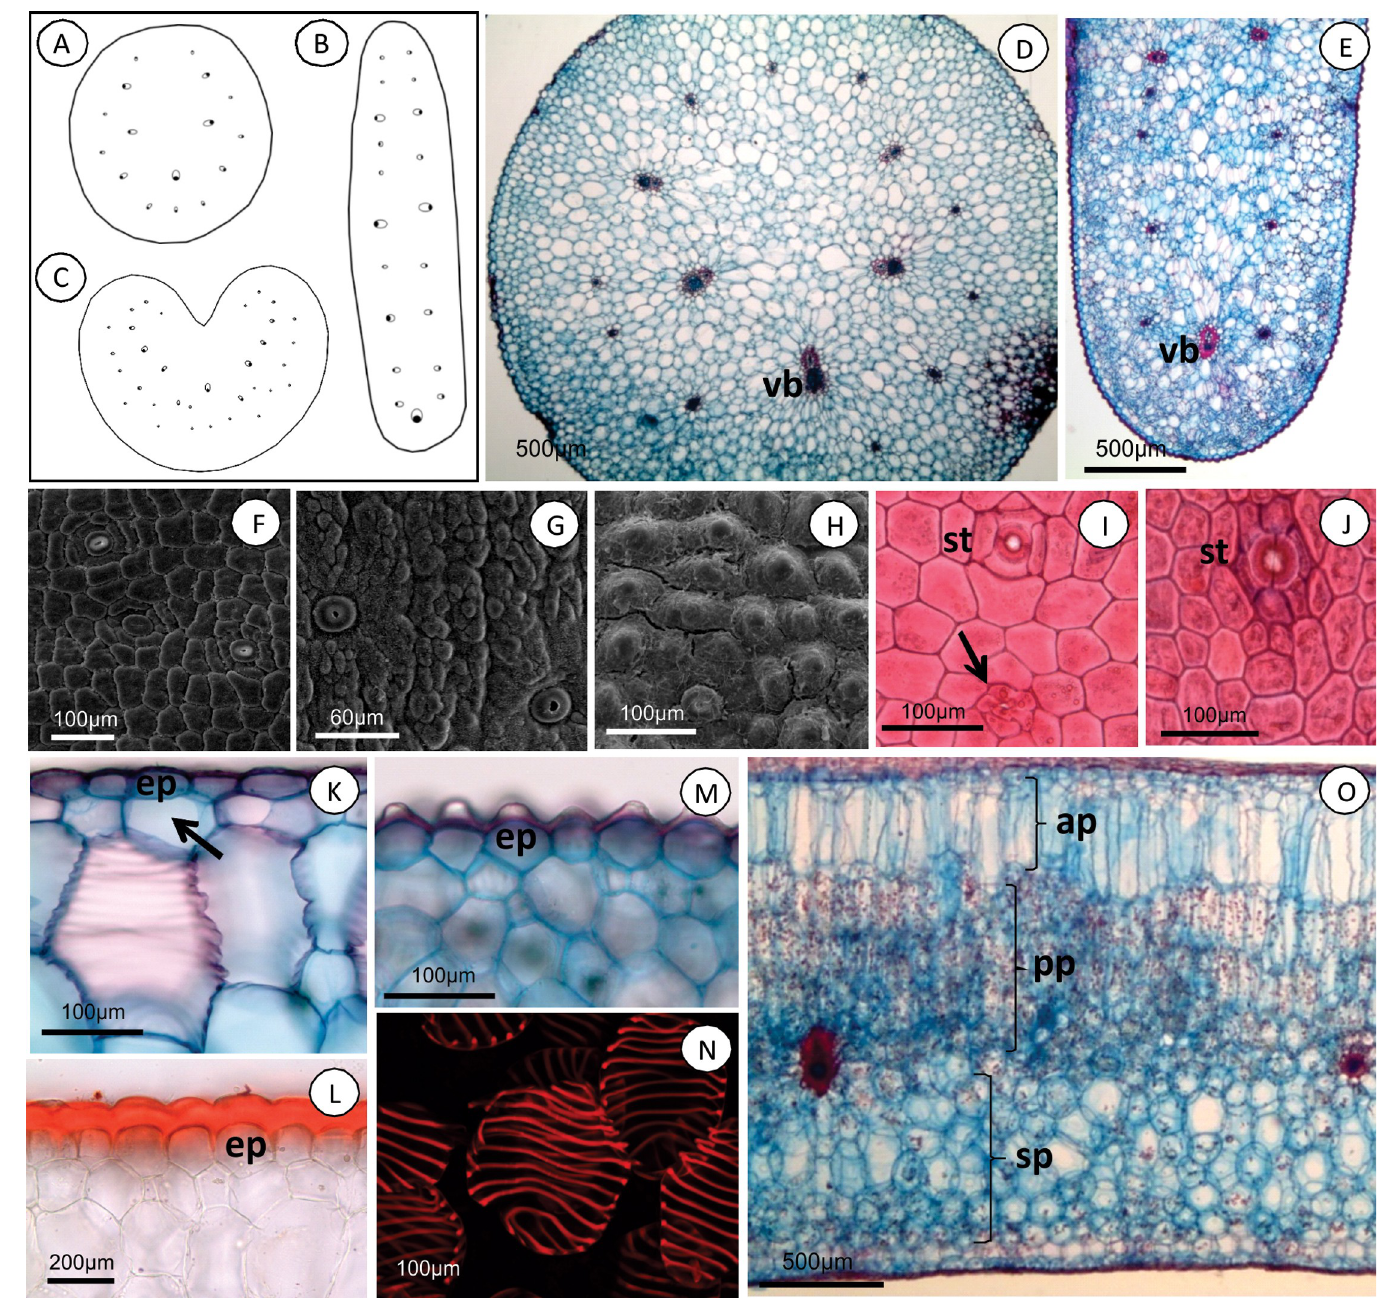
Fig 3. Acianthera leaf blades. Schematic drawing of cross-sections (A-C), cross-sections under light microscopy (D and E), frontal view under SEM (F-H), and light microscopy (I-O). (A) A . atropurpurea , line drawing highlighting organization of vascular bundles in mesophyll. (B) A . crepiniana , line drawing of elliptical leaf highlighting organization of vascular bundles in mesophyll. (C) Acianthera teres , round-sulcate leaf showing adaxially facing phloem. (D) Acianthera mantiquyrana , circular leaf, showing wider vascular bundles (vb) towards the medial region and outside-facing phloem. (E) Acianthera crepiniana , elliptical leaf with two parallel vascular bundles (vb) of larger diameter in basal area. (F) Acianthera saurocephala , smooth epidermis. (G) Acianthera luteola , verrucous epidermis. (H) Acianthera crepiniana , papillose epidermis. (I) Acianthera atropurpurea , epidermis with trichome insertion scars (arrow). (J) Acianthera teres , epidermis showing stomatal complex with six subsidiary cells. (K) Acianthera saundersiana , polygonal cells in epidermis (ep) and single-layered adaxial hypodermis (arrow). (L) Acianthera teres , dome-shaped epidermal cells (ep), and cuticle with Sudan III reaction. (M) Acianthera crepiniana , papillose epidermis (ep). (N) Acianthera prolifera , round tracheoidal idioblast in mesophyll. (O) Pleurothallopsis nemorosa , heterogeneous mesophyll with aquiferous parenchyma (ap), palisade parenchyma (pp) and spongy parenchyma (sp).